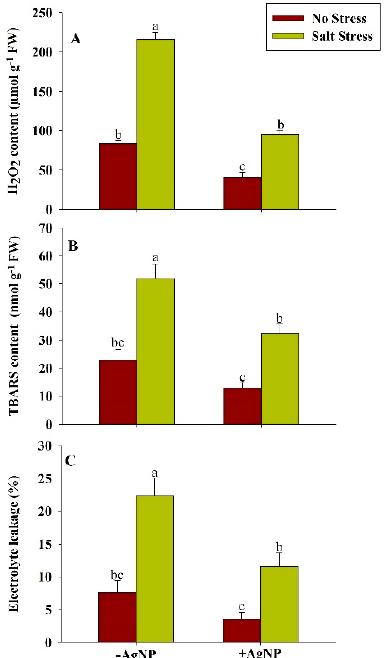
Figure 3. Estimation of oxidative-stress biomarkers: ( A ) Hydrogen peroxide (H 2 O 2 ), ( B ) thiobarbituric acid reactive substances (TBARS), and ( C ) electrolyte leakage (EL) content in wheat at 30 DAS. Plants were grown individually with 0 (control), 100 mM NaCl, 300 ppm AgNPs and NaCl combined with AgNPs. Data are presented as treatments mean ± SE (n = 3). Data followed by same letter are not significantly different by LSD test at ( p ˂ 0.05).